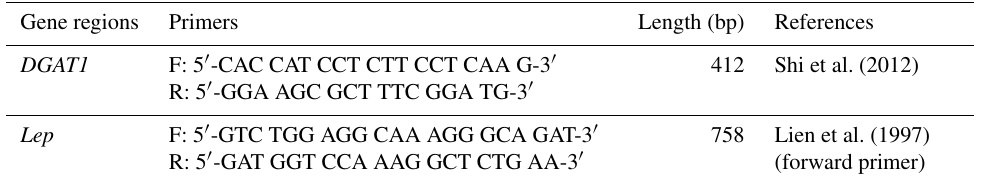
Figure 1. Location of the Anatolian water buffalo samples collected in this study. Table 1. Primer sequences of DGAT1 and Lep